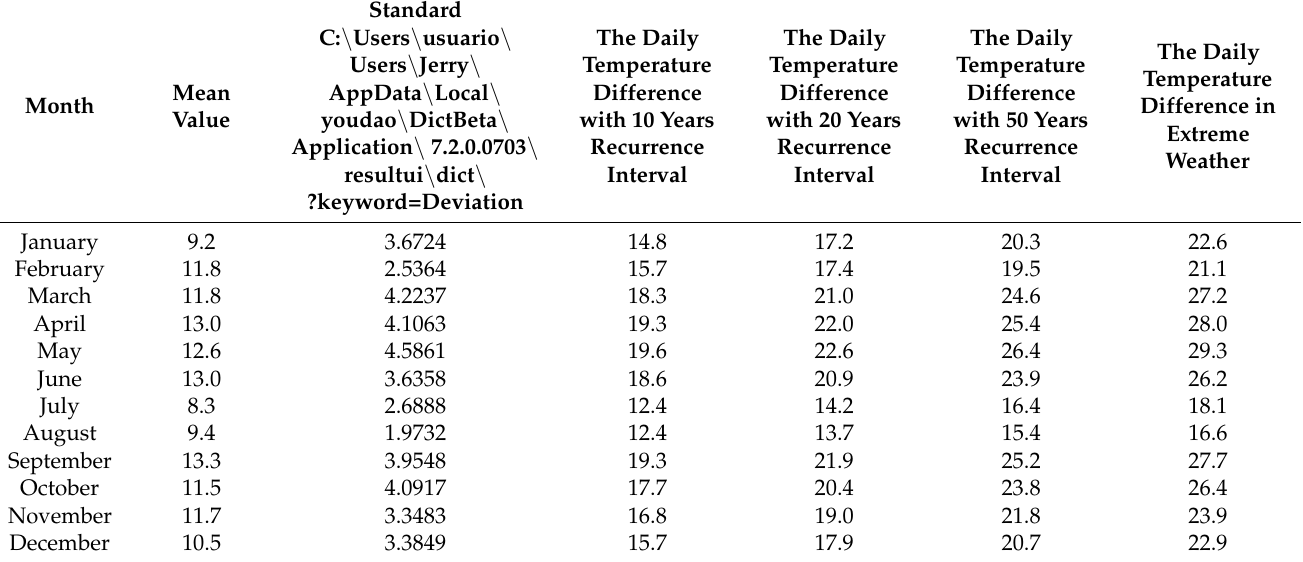
Table 2. Diurnal temperature range each month in Beijing ( ◦